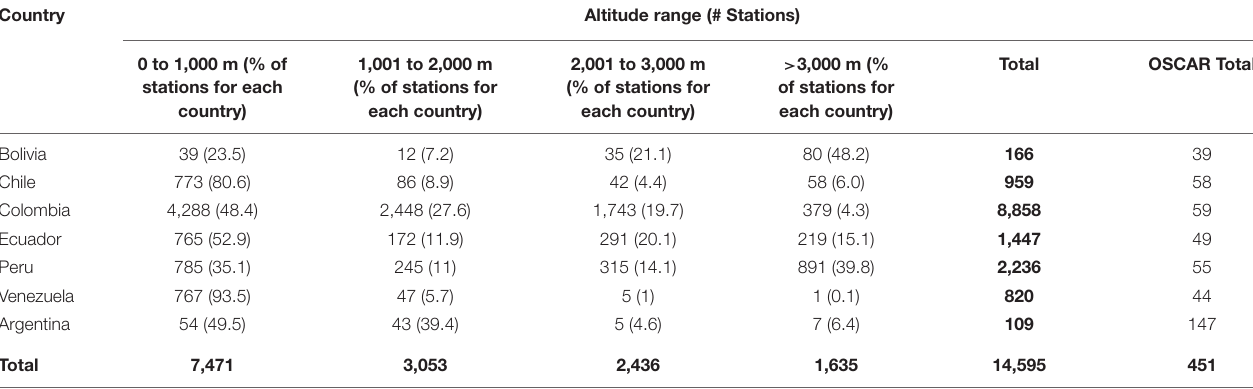
TABLE 2 | Total number of stations (meteorological and hydrological) per country and altitude range based on the reports received from the NMHSs in Bolivia, Colombia, Chile, Ecuador, Peru, Venezuela, and Argentina. Country Altitude range (# Stations) > 3,000 m (% 0 to 1,000 m (% of 1,001 to 2,000 m 2,001 to 3,000 m Total OSCAR Total stations for each (% of stations for (% of stations for of stations for country) each country) each country) each country) Bolivia Chile 773